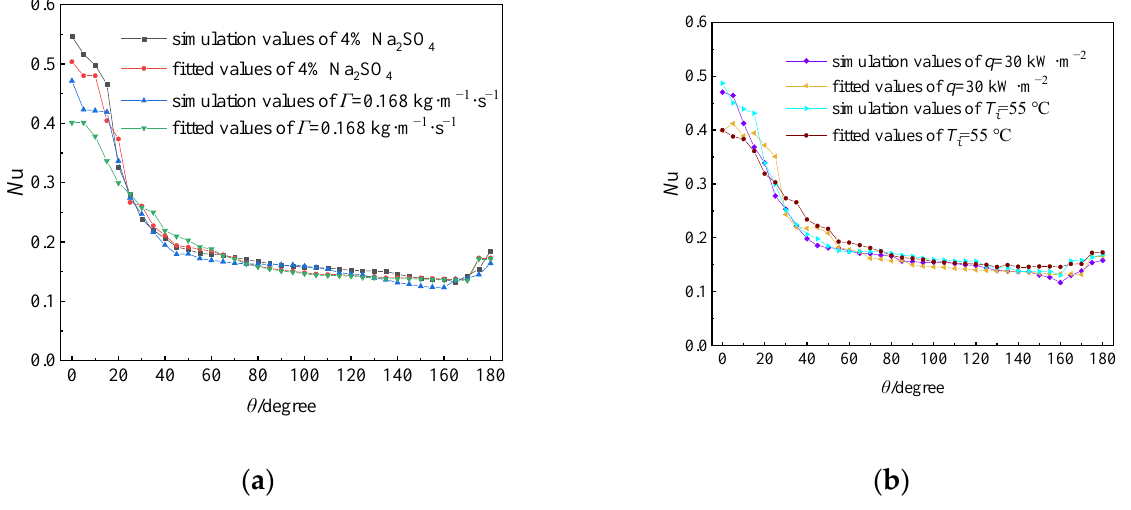
Figure 11. Error comparison diagram of the fitted and simulated data. ( a ) Error comparison diagram of Na 2 SO 4 content and spray density. ( b ) Error comparison diagram of heat flux and spraying temperature.